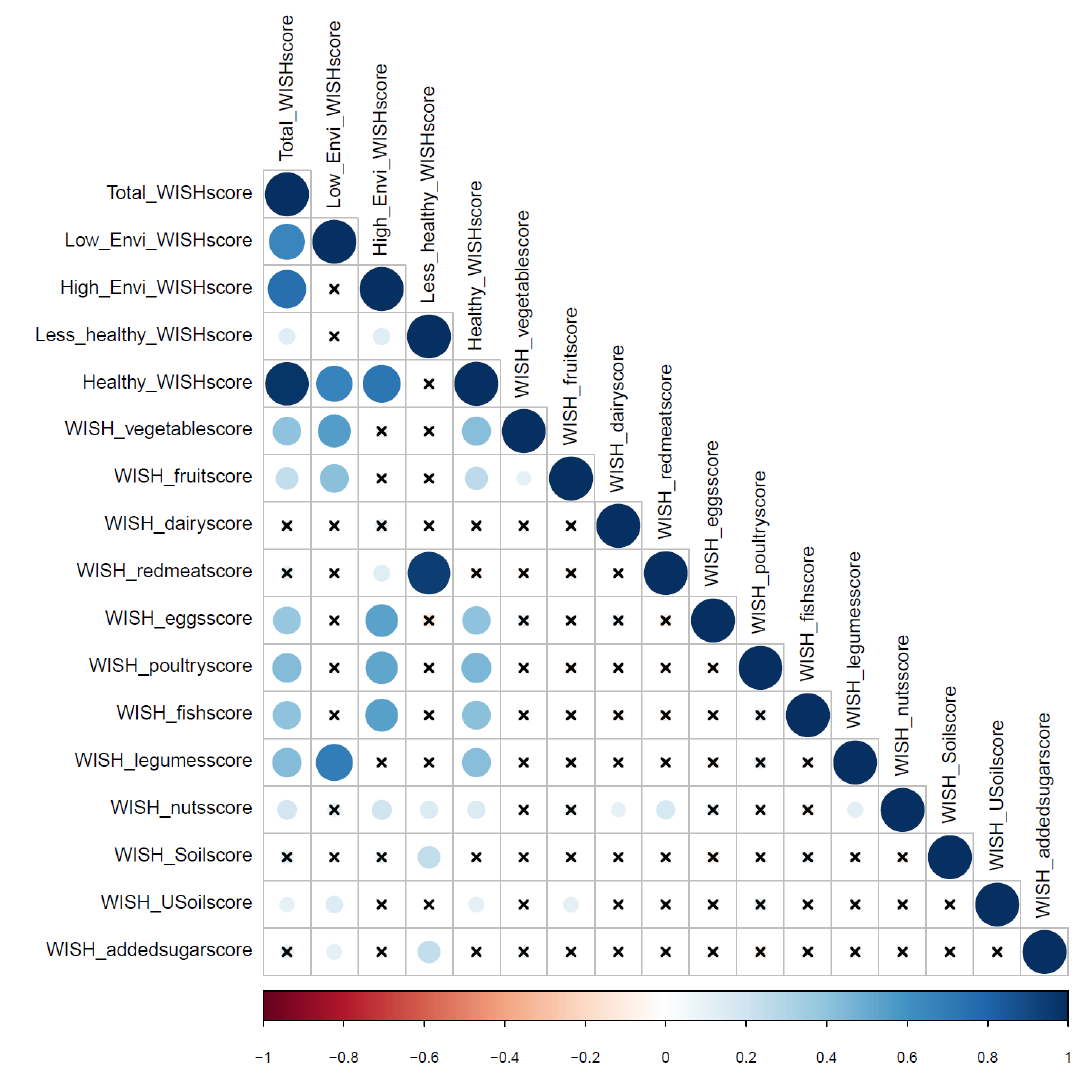
Figure 3. Heatmap of Spearman correlations amongst components scores, total WISH and sub scores (insignificant p values (significance level p ≤ 0.05) are crossed), the WISH score for whole grains is not shown as the majority of the population scores 0, and thus no correlation could be made. Larger circles mean a stronger correlation (for positive and negative correlations). WISH_USoilscore: unsaturated oil WISH score; WISH_Soilscore: saturated oil WISH score.